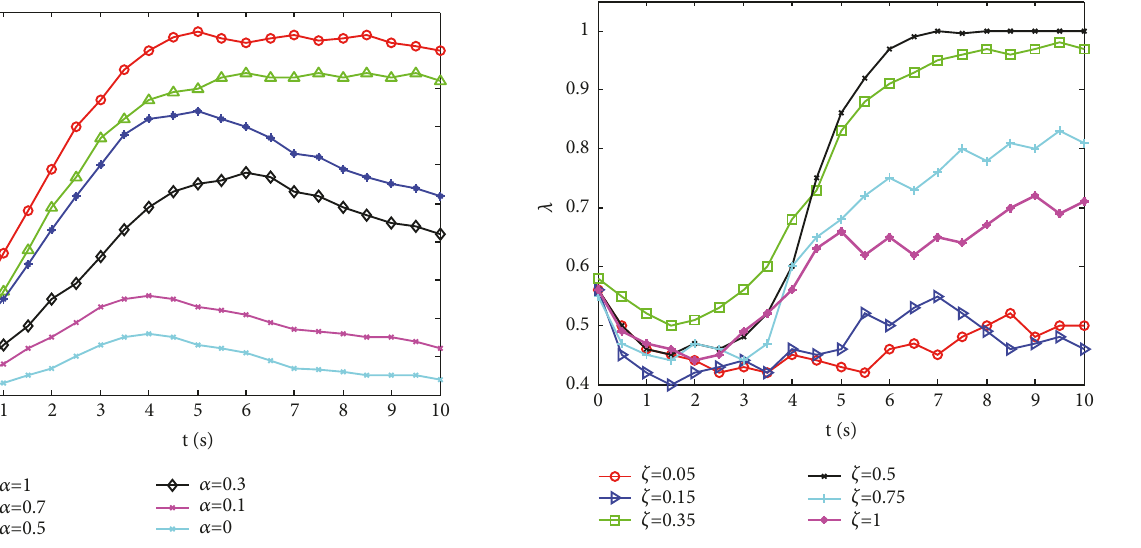
fission behavior tends to happen. If 𝛼 further decreases, the polarization index will keep a low value in the fusion